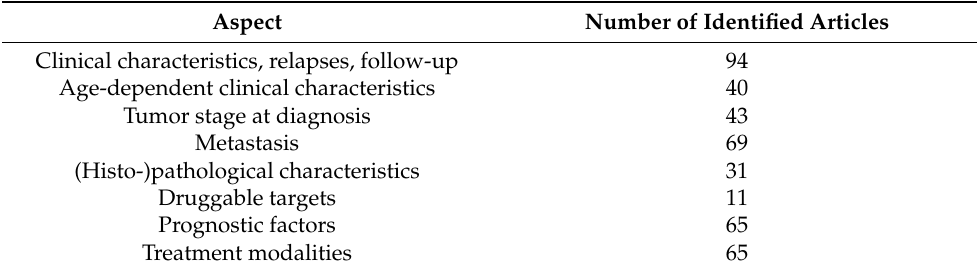
Table 1. Aspects of research. Analyzed topics and numbers of the identified